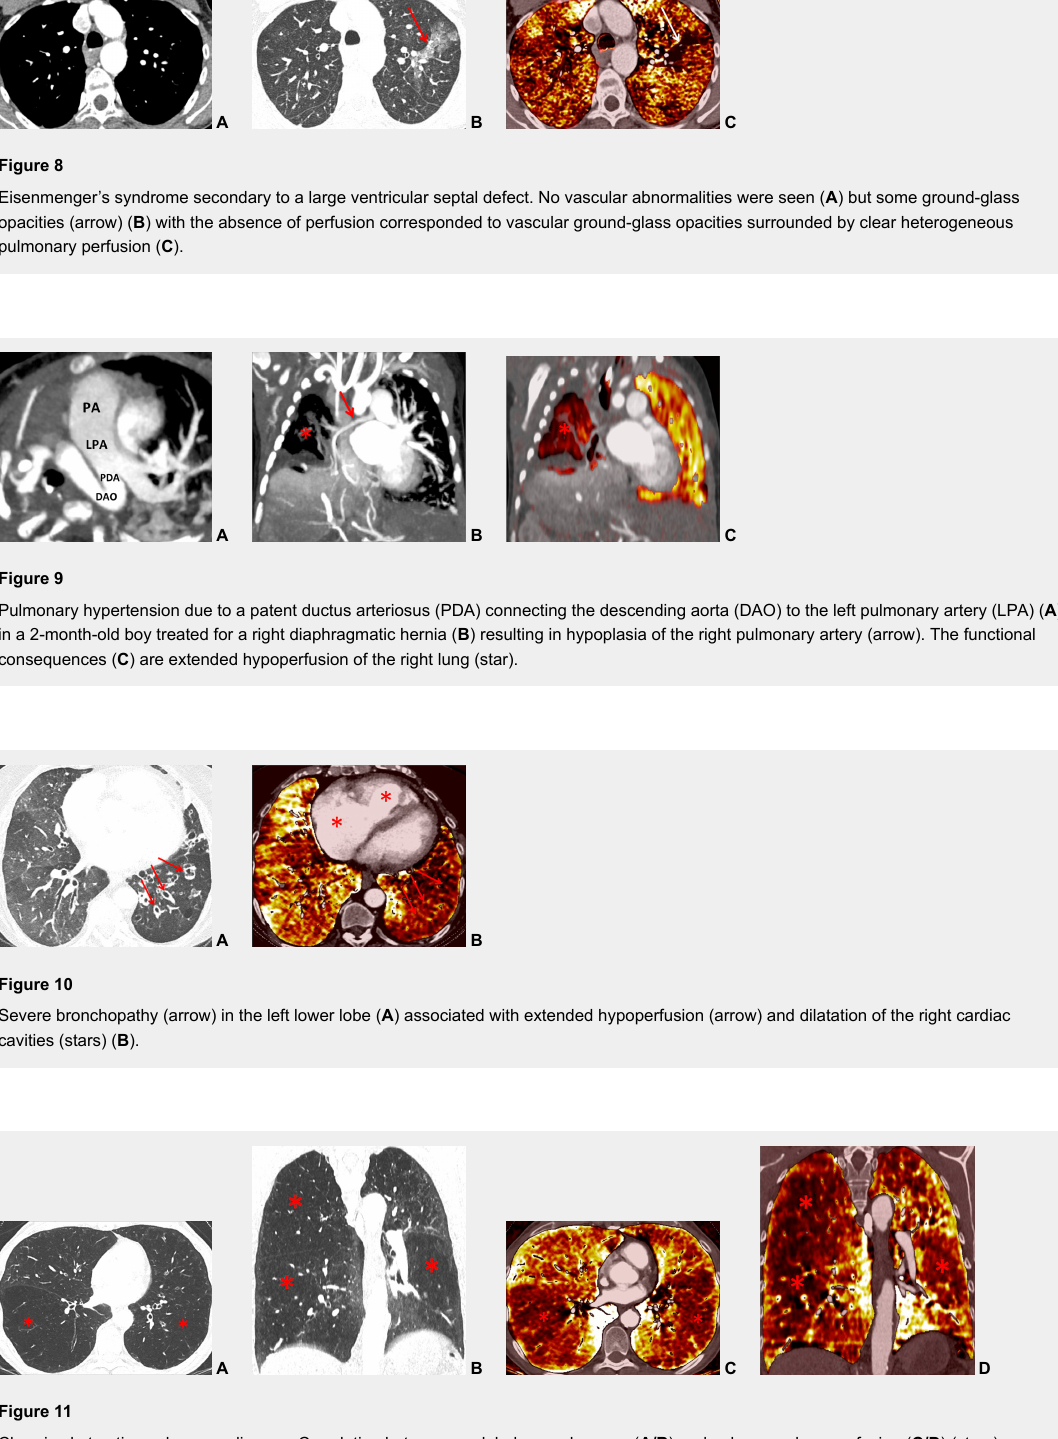
Chronic obstructive pulmonary disease. Correlation between panlobular emphysema ( A/B ) and pulmonary hypoperfusion ( C/D )